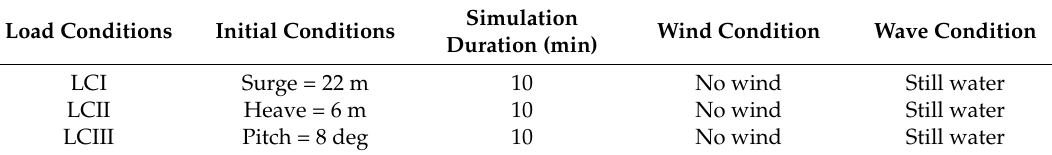
Table 3. Load conditions in the free-decay test. LC = load condition. Table 4. Load-condition definitions for the regular and irregular waves.